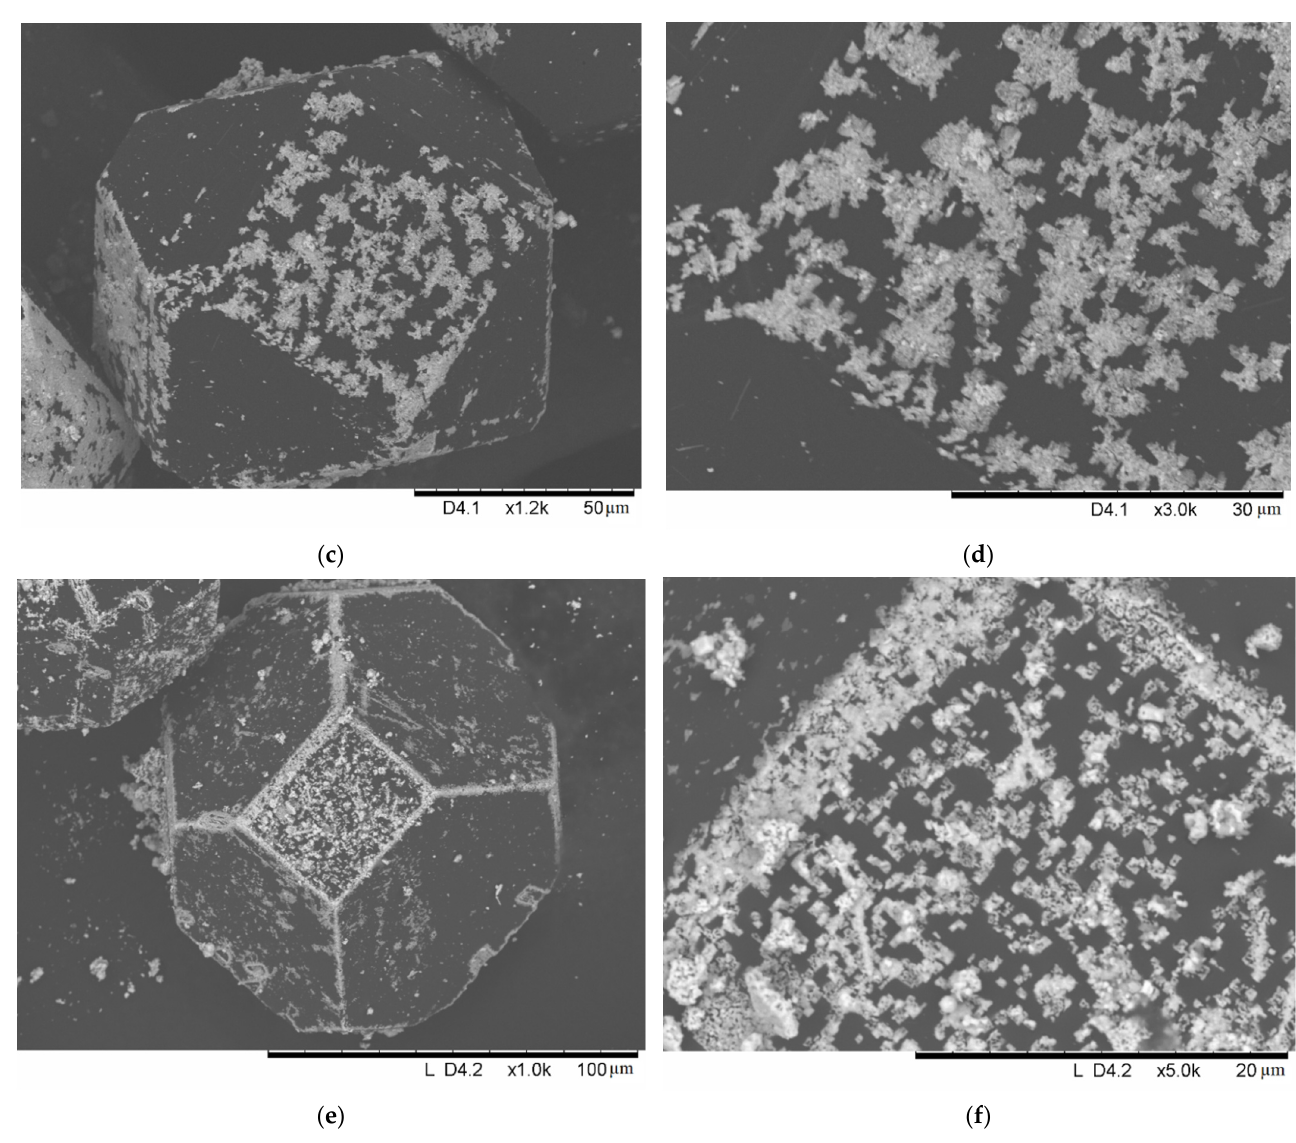
Figure 1. Surface of the diamond crystals: 10-900-5-HP ( a ), 10-900-15-HP ( c ), and 10-900-30-HP ( e ). Morphology of the Mo-containing island structures on the diamond surface on the {100} facets ( b , d , f ).